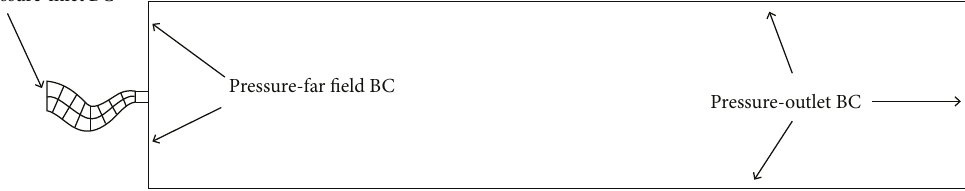
Figure 6: Boundary conditions.